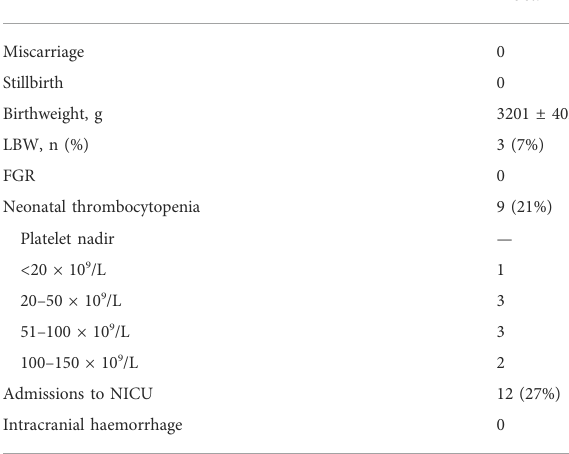
TABLE 4 Neonatal outcomes for 44 infants of 43 women with low-